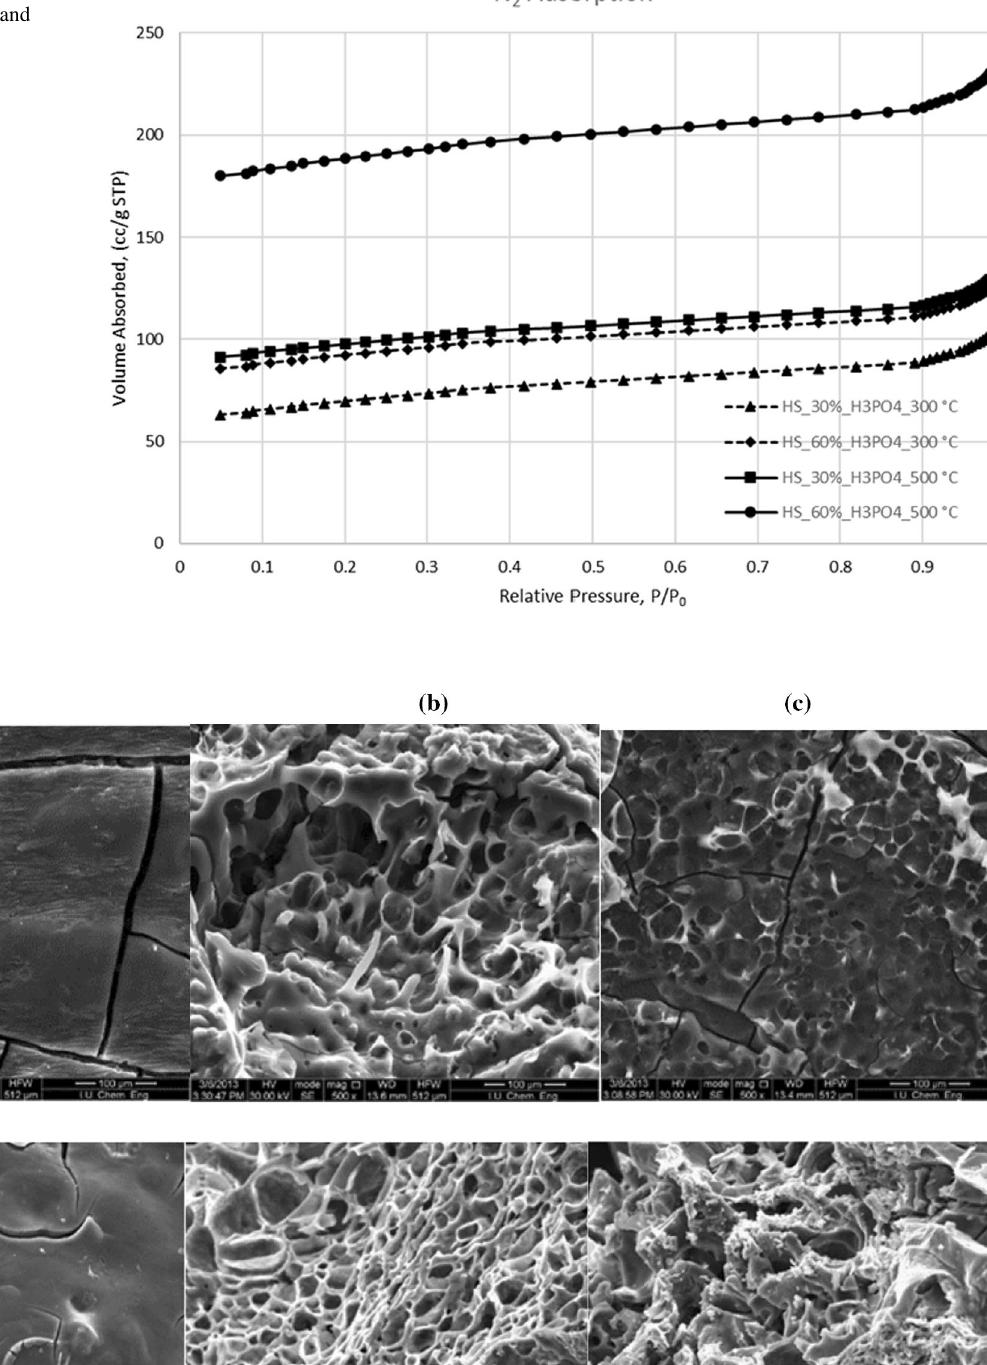
2 , and c treated